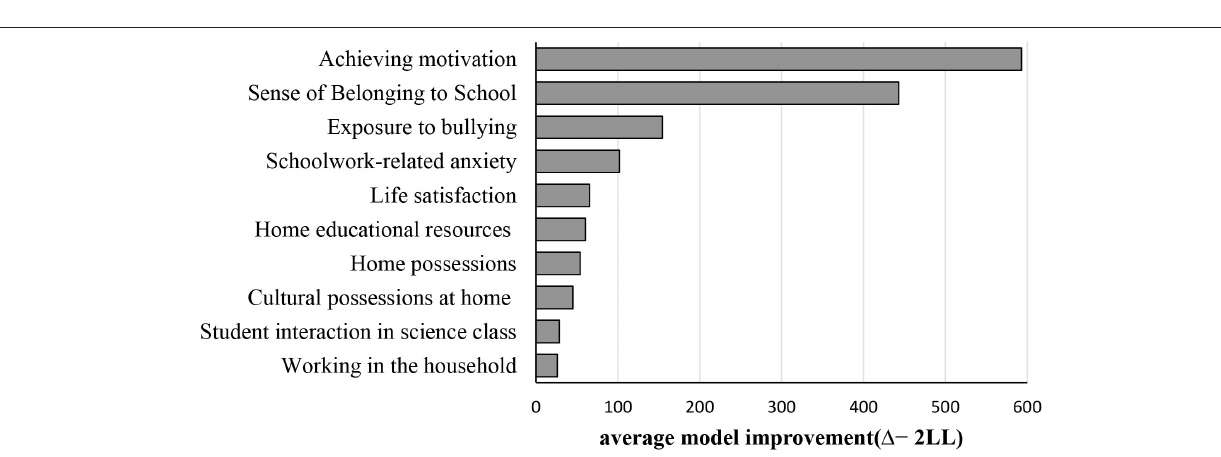
FIGURE 5 | Top 10 variable importance of complete SEM Forest. The x-axis shows the average model improvement ( 1 two-group model splitting on a covariate. The length of the bar represented the variable importance of each covariable for the factor model, quantified as average increase in model misfit due to